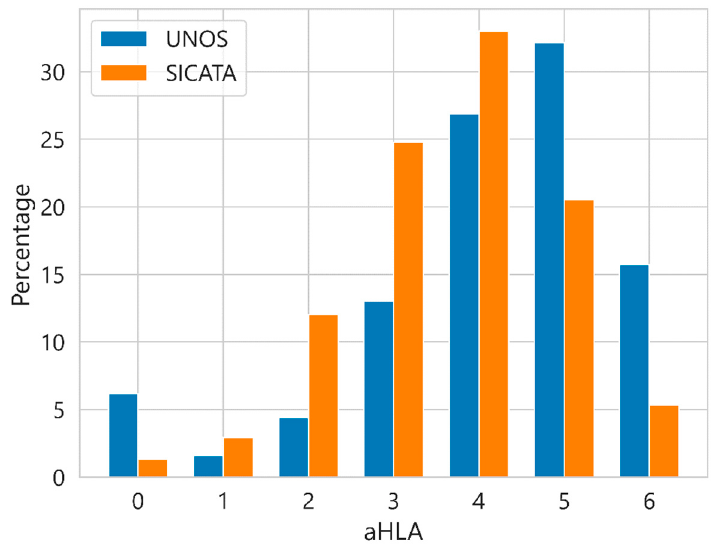
Figure 5. Percentage of cases with respect to the total considering the different aHLA values in UNOS and SICATA.